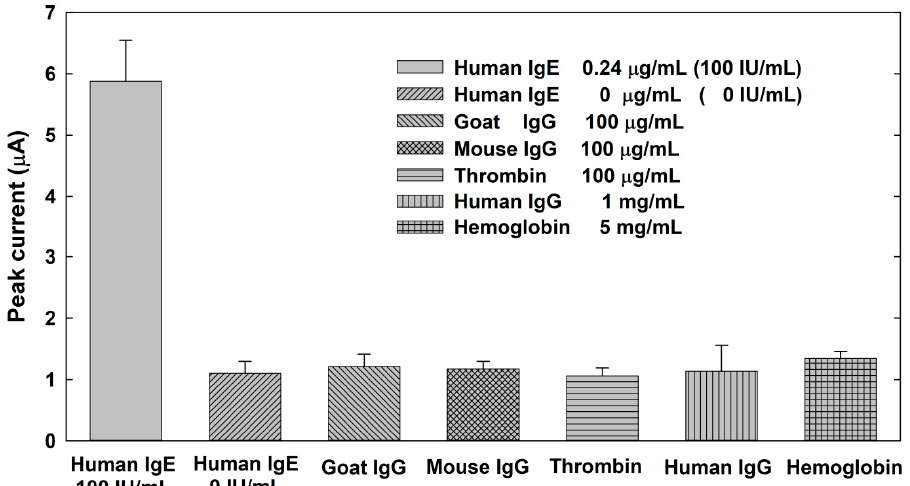
Figure 4. Selectivity tests using different targets: goat IgG, mouse IgG, thrombin, human IgG, hemoglobin, 0 IU / mL of target IgE, and 100 IU / mL of target IgE. Each experiment was performed at least three times.